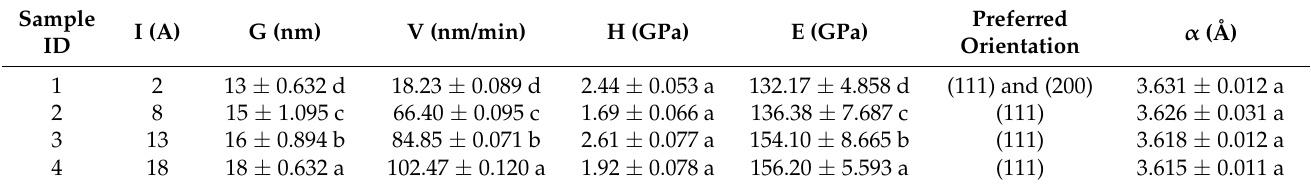
Table 1. Experimental results of the Cu coatings deposited at different target currents 1